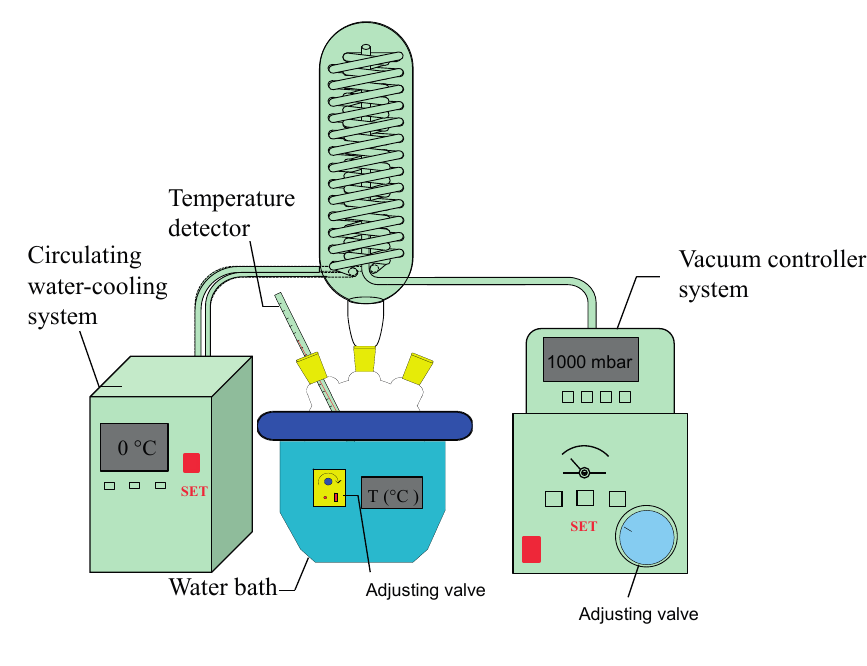
Figure 2. The VAE